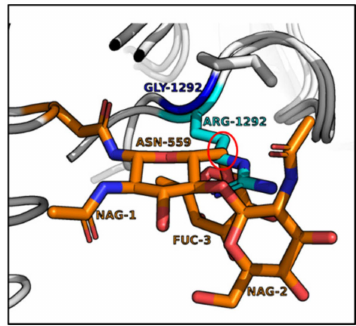
Figure 6. The guanidinium ring of R1292 disrupts the glycan-N559 network in a modeled HCC/A1(G1292R)-LD4 of SV2C complex. The corresponding region of HCC/A4 (PDB:6F0P) was overlapped on the cocrystal of HCC/A1-LD4 of SV2C (PDB:5JLV). Note the extension of the guani- dinium ring of R1292 into the glycanN559 network (red